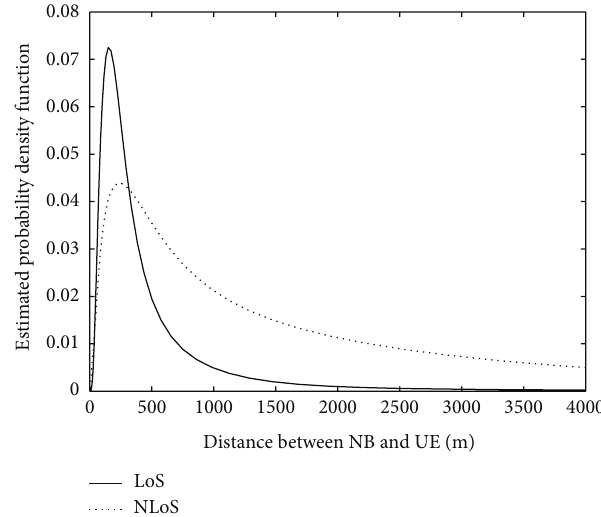
Figure9: Theempirical pdfsofestimated pathlossinLoS andNLoS scenarios.